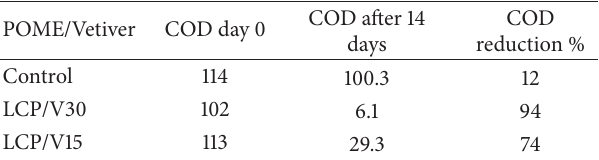
Table 6: Reduction of COD in low concentration POME with different Vetiver